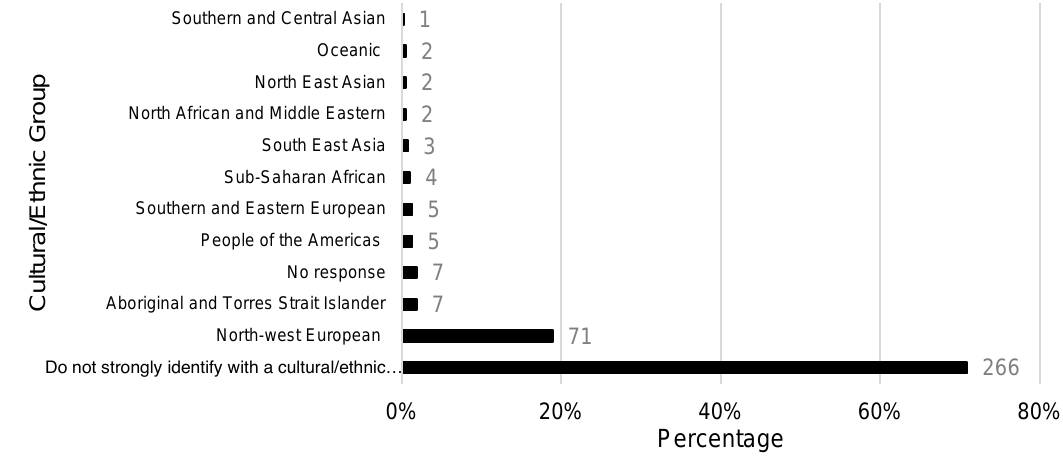
Figure 2. Cultural and ethnic group identification of participatory and deliberative practitioners